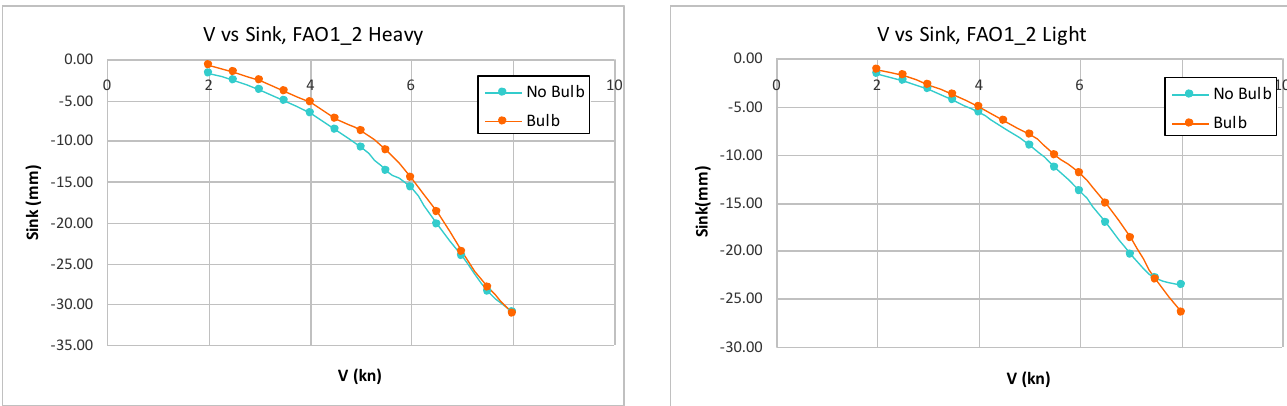
Figure 22. FAO3 vs. FAO4 at 8.5 kn, heavy conditions.